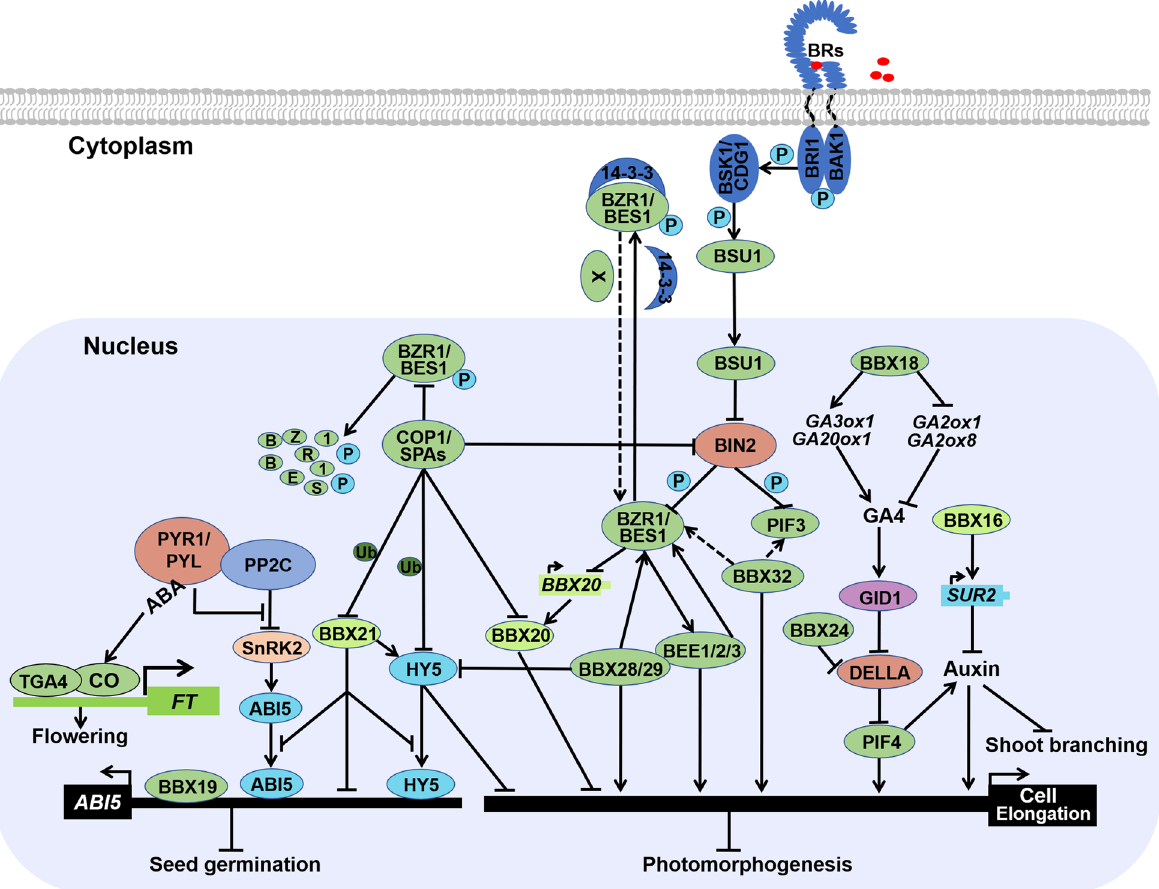
Fig. 5 BBX proteins in phytohormone-mediated growth and development. BBX proteins are involved in phytohormone signaling to control plant growth and development. BBX16 augments SUR2 expression to reduce auxin level. BBX18 increases GA level via elevating GA catabolic related genes and suppressing GA metabolic related genes to promote hypocotyl elongation. BBX24 interacts with DELLA to alleviate DELLA-mediated inhibition of PIF4. BBX32 interacts with BZR1 to control BR-induced cotyledon closure. BZR1 represses the gene expression of BBX20 . BBX21 associates with HY5 and ABI5 to repress the expression of ABI5 to promote seed germination. BBX19 directly binds to the promoter of ABI5 to inhibit seed germination. In addition, ABA induces flowering possibly via improving the transcriptional activity of